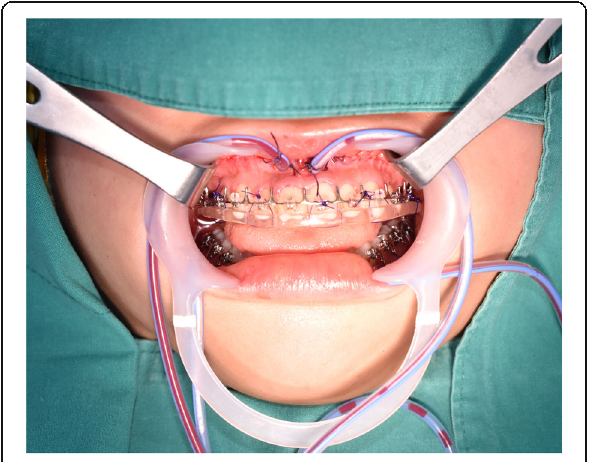
Fig. 1 The drainage tube inserted on the maxillary Le Fort I osteotomy and anchored to the maxillary labial